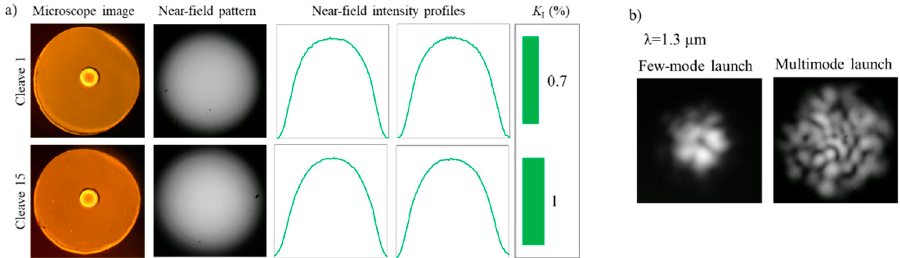
Figure 9. ( a ) Cleaves performed at temperature ≈ 90 °C and rotation speed of 0.19 degrees/s (28 s per cleave) using the Wilkinson RB. Two examples (cleave no. 1 and cleave no. 15) of a series of 20 consecutive cleaves performed using the same part of the same RB. ( b ) Near-field images of the speckle patterns obtained using distributed feedback (DFB) laser with λ = 1.3 µm and a single-mode pigtail utilizing central and offset launch.